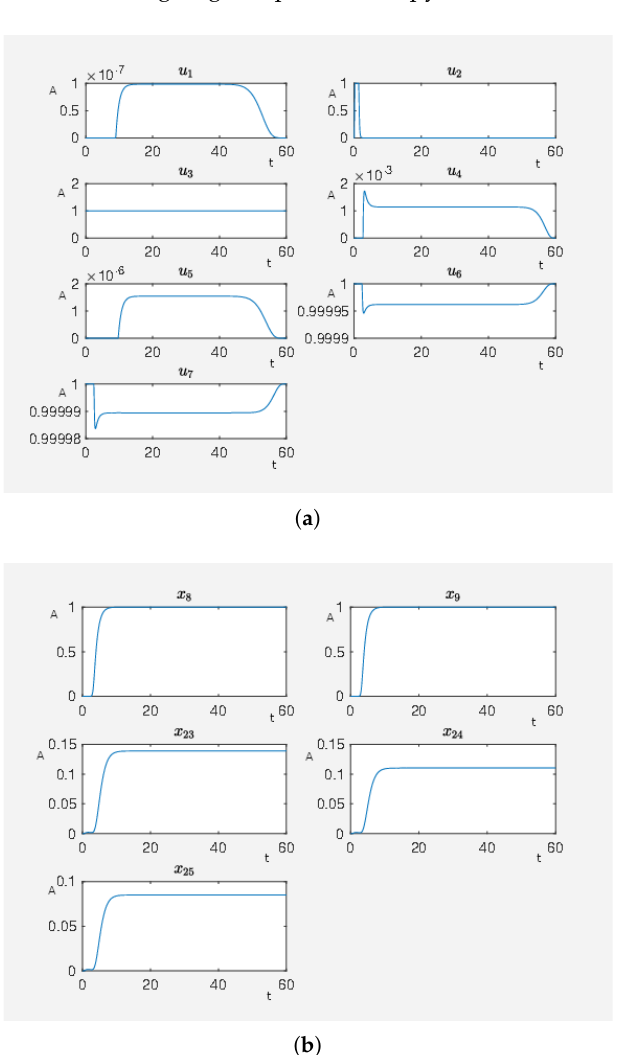
Figure 11. Several external stimuli acting on the cardiomyocyte. ( a ) Time curve of external stimuli where u 1 inhibits PKC, u 2 inhibits RKIP and RKIP dim, u 3 inhibits ERK1/2 dim 3P, u 4 G s -coupled β 1 receptor, u 5 inhibits Ras (GTP bound), u 6 activates angiotensin II and u 7 activates isoproterenol. On the abscissa, we have the time (t) and on the ordinate the activity level (A). ( b ) Time curve of the nodes of interests where x 8 is the activity level of p90RSK, x 9 is the activity level of p70S6K, x 23 is the activity level of Elk1, x 24 is the activity level of MSK1 and x 25 is the activity level of c-Myc. On the abscissa, we have the time (t) and on the ordinate the activity level